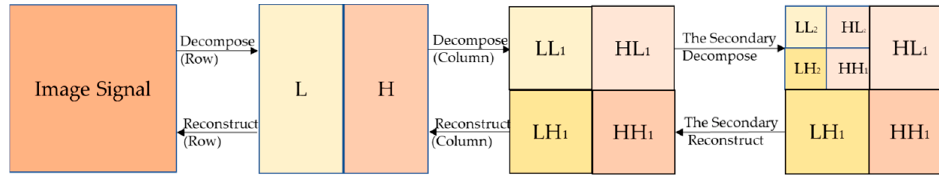
Figure 6. The frame of the RPM-K-Means model. The 𝐿𝐿 subband was an approximate representation obtained using a low-pass wavelet filter. The 𝐻𝐿 subband was obtained using a low-pass wavelet filter and a high- pass wavelet filter, which showed the singularity of the image in the horizontal direction. The 𝐿𝐻 subband was obtained using the aforementioned two filters and represented the singular characteristics of the image in the vertical direction. The 𝐻𝐻 subband, obtained using a high-pass wavelet filter, indicated the diagonal edge characteristics of the images. Different measures were taken for the low-frequency and high-frequency components to improve the contrast of the images and strengthen the texture details in the images. If the low-frequency coefficient was greater than 250, it was multiplied by 0.75. If the high-frequency coefficient was less than 150, it was multiplied by 1.25. The aforementioned process is depicted in Figure 7.